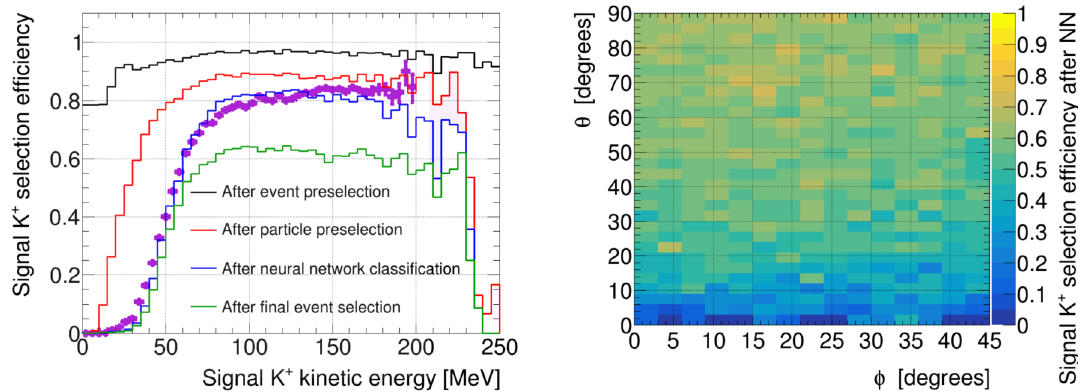
Figure 9 . Left: signal K + selection efficiency as a function of true kinetic energy throughout the analysis. Since every signal event contains exactly one K + in the reference sample, the y-axis can also be interpreted as signal selection efficiency. The purple points show the signal K + tracking efficiency for a similar study reported in [48] and are put into context at the end of section 4. Right: signal K + selection efficiency as a function of true K + start direction after the neural network (NN) classification. The ranges of θ and φ have been downsized by exploiting different symmetries in the detector: φ = 0 ◦ is parallel to the readout strips in one of the readout views and φ = 45 ◦ is in the middle of both readout view orientations. θ = 0 ◦ is parallel and antiparallel to the drift direction and θ = 90 ◦ is parallel to the charge readout plane. The selection efficiency decreases significantly for kaons that travel parallel or antiparallel to the drift direction ( θ = 0 ◦ ) but is stable for kaons that travel parallel to the readout strips in one of the readout views ( φ = 0 ◦